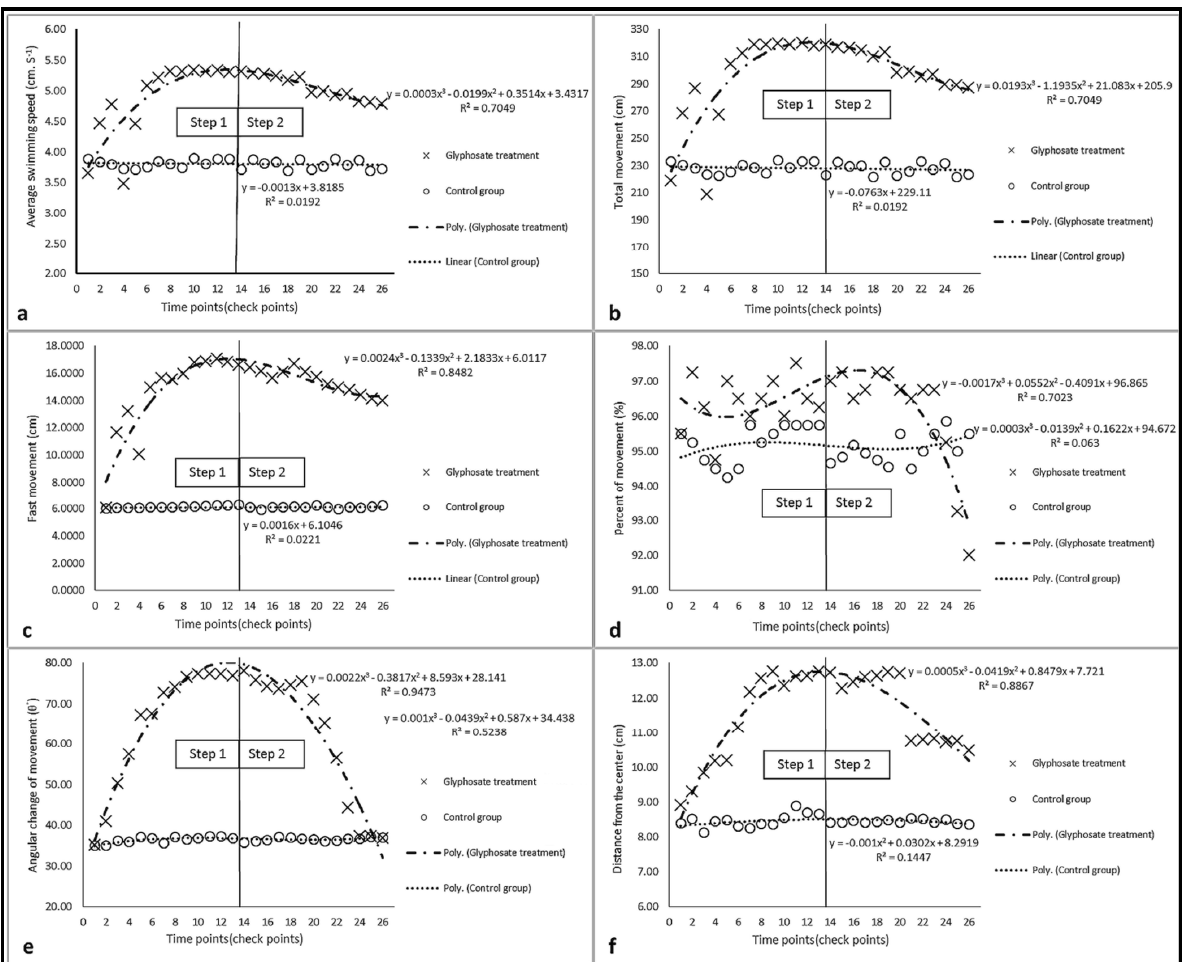
Figure 6. Diagrams of swimming parameters of fish in the test steps: ( a ) average speed; ( b ) total movement; ( c ) fast movement; ( d ) percent of movement; ( e ) average angular change of movement; ( f ) distance from the center.